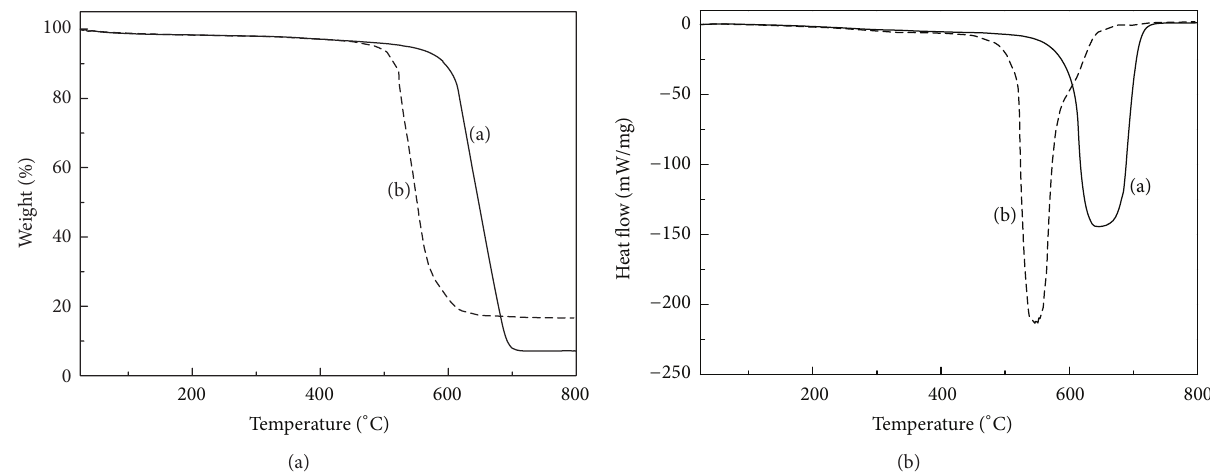
Figure 4: TG and DSC curves of TiO 2 -CNx composites with different weight ratio of TiO 2 over CNx 5% (a) and 15%